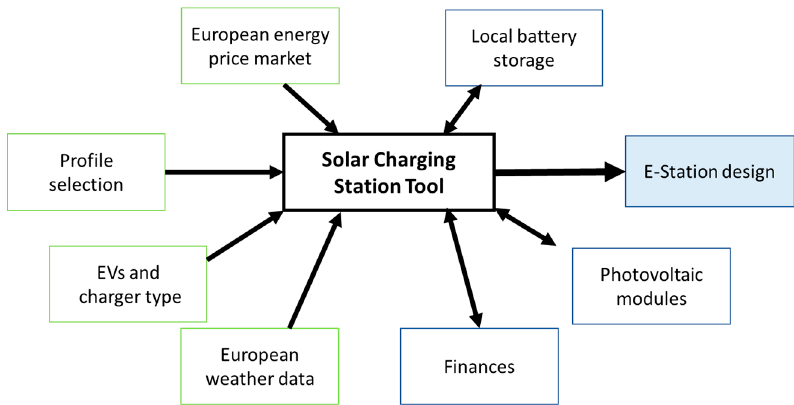
Figure 12. Mind map of solar charging station tool.